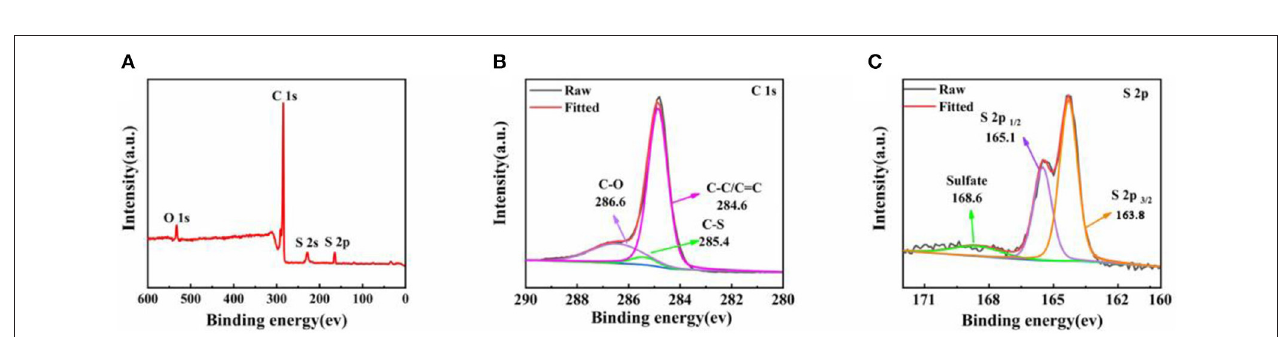
FIGURE 4 | X-ray photoelectron spectroscopy (XPS) survey spectrum of helical carbon nanotubes (HCNT)/reduced graphene oxide (rGO)/sulfur (S) composites (A) ; C 1s (B) , and S 2p (C) XPS spectra of the HCNT/rGO/S composite.